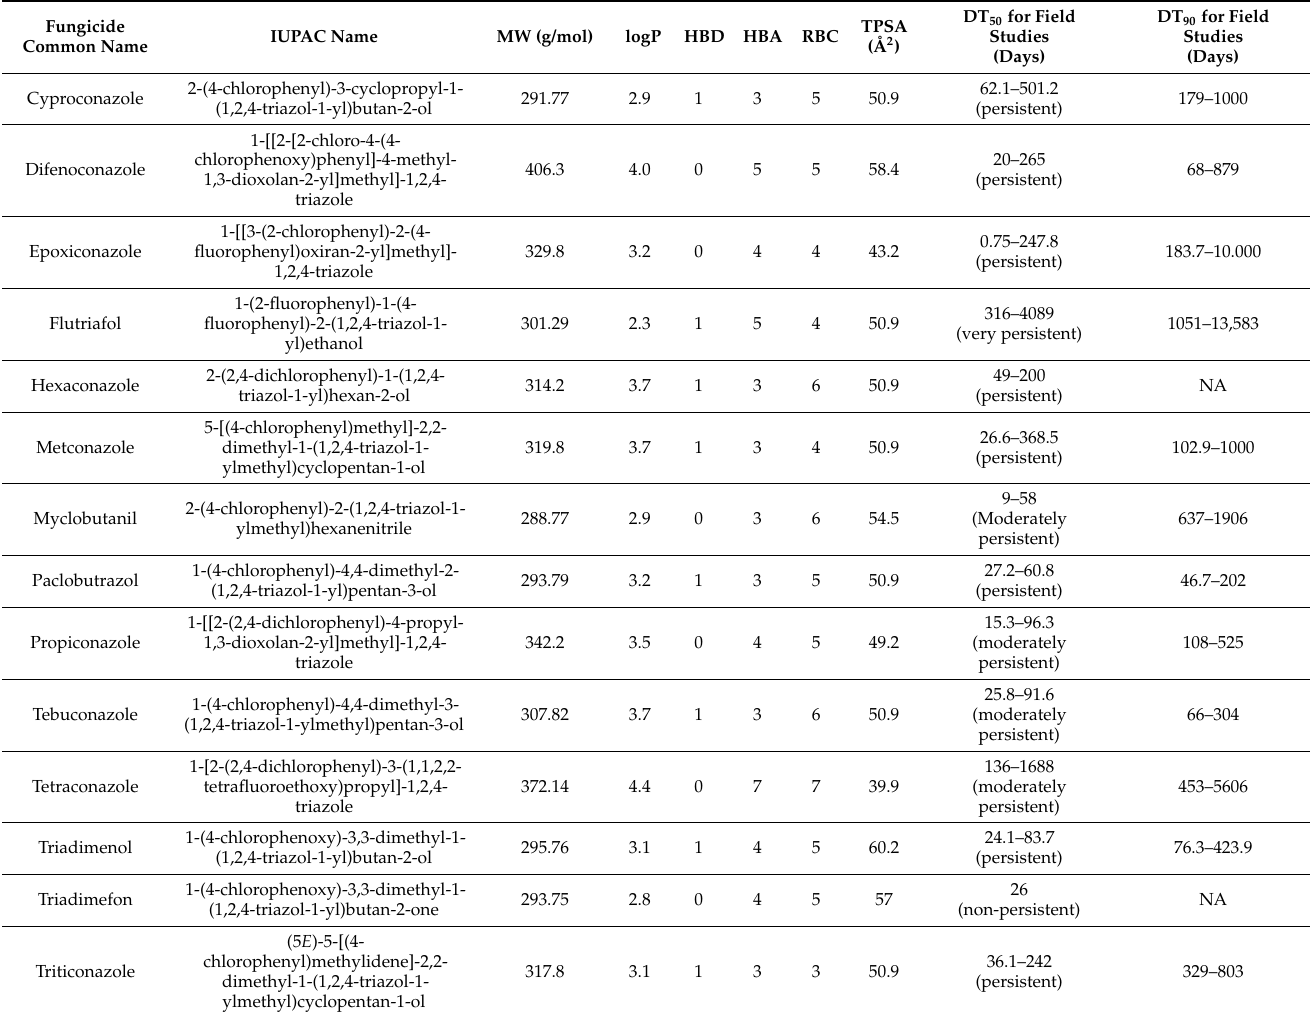
Table 1. IUPAC names, physicochemical and degradation rates of investigated triazole fungicides: MW—molecular weight, logP—partition coefficient, HBD—hydrogen bonds donors, HBA—hydrogen bonds acceptors, RBC—rotatable bonds count, TPSA—topological polar surface area, DT 50 and DT 90 the periods after that 50% and respectively 90% of the fungicide to be